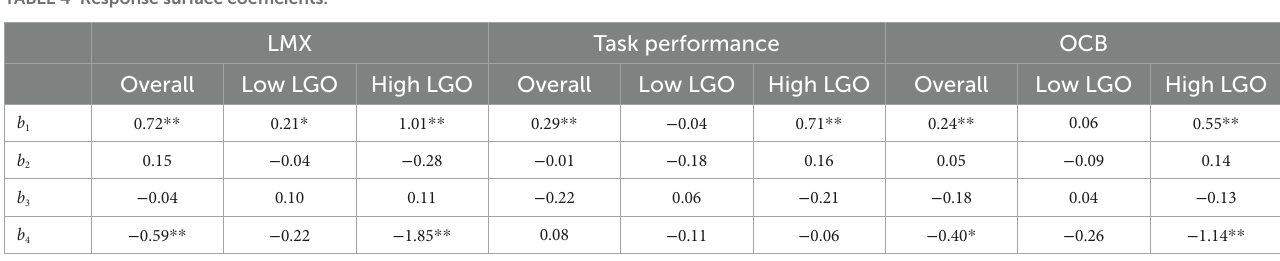
TABLE 4 Response surface coefficients. LMX Task performance